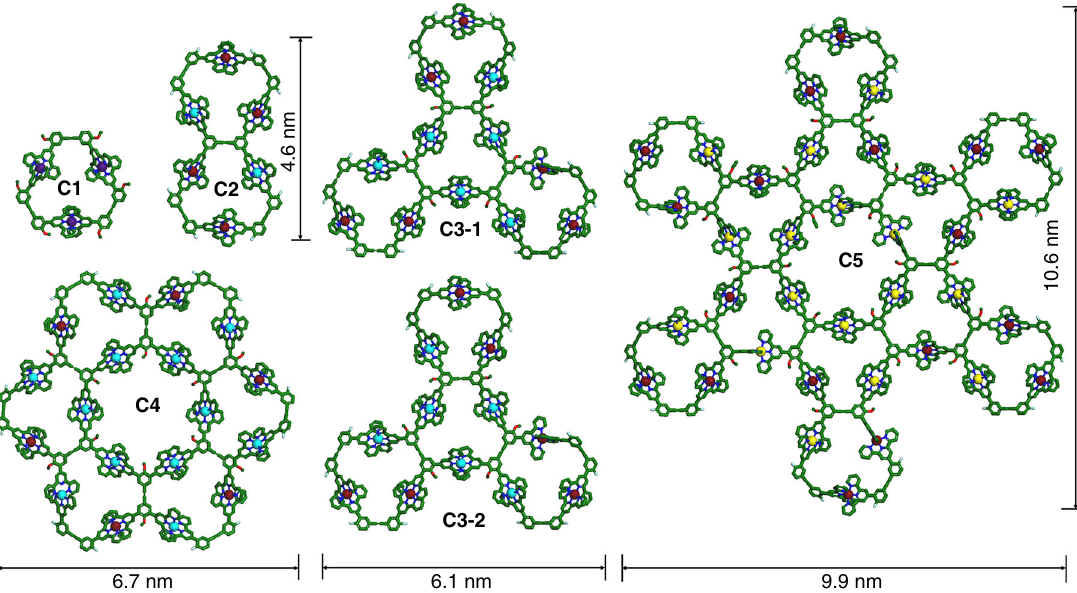
Fig. 1 Energy-minimized structures of supramolecular cycles C1 – C5 . C1 : violet = Fe; C2 : cardinal = Ru, blue = Zn; C3 – 1 & C3 – 2 : cardinal = Ru, blue = Zn; C4 : cardinal = Ru, blue = Zn; C5 : cardinal = Ru, yellow = Cd. Alkyl chains were omitted for clarity